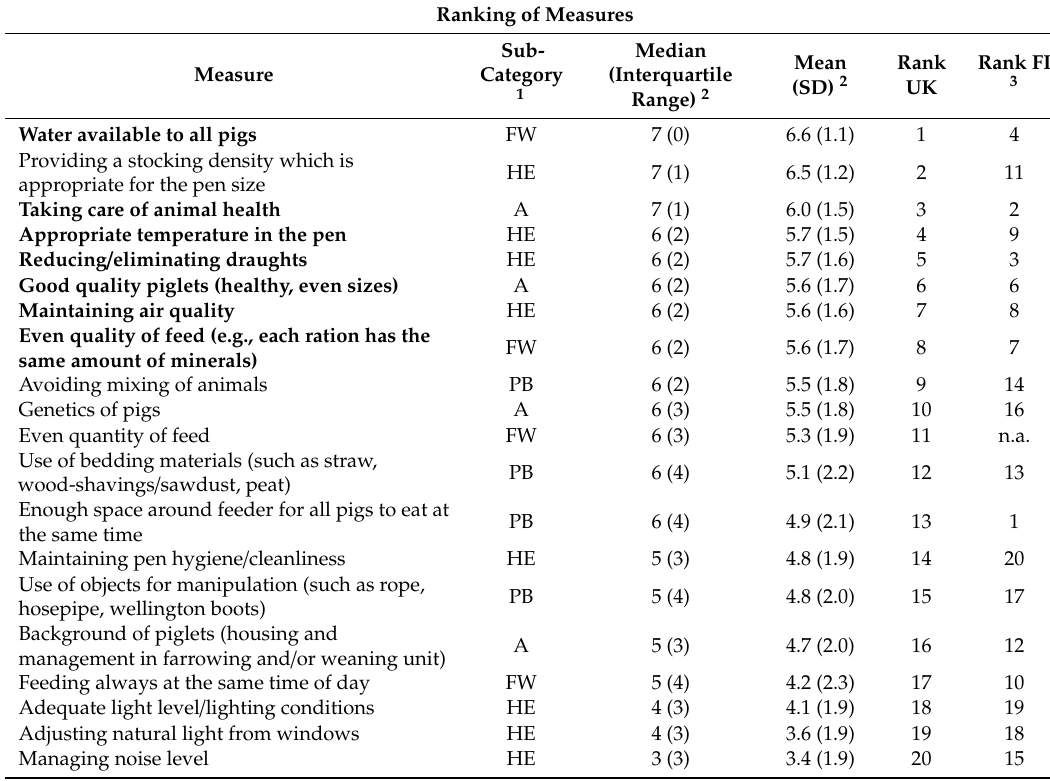
Table 4. Perceived importance of the di ff erent preventive measures for tail biting given in the questionnaire. The last two columns indicate the ranking of the measures according to UK (current study) and Finnish pig producers (FI) (based on Valros et al. 2016 [13]). Measures rated within the top 10 in both countries are indicated by bolded